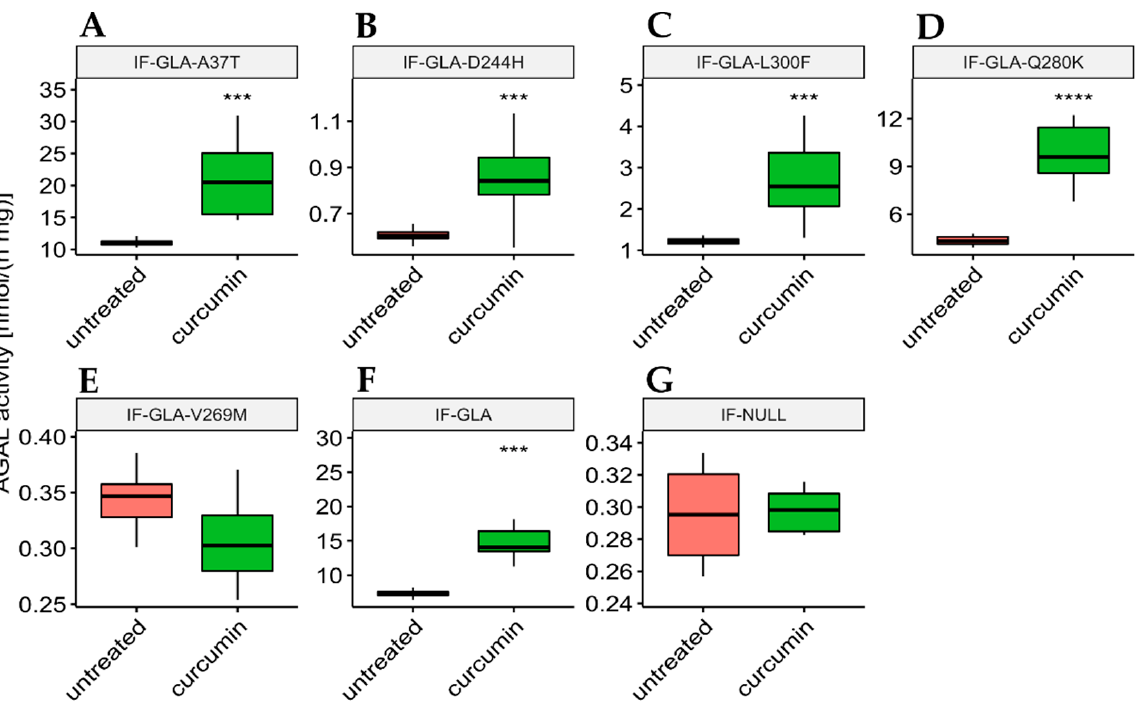
Figure 1. Curcumin treatment enhanced AGAL activity. IF-GLA and IF-GLA-MUTs were treated with 20 μ M curcumin for 48 h. The AGAL-specific activity was then tested on cell protein extracts. Wild-type cells and four mutants showed a significant AGAL improvement upon curcumin treatment (two-tailed unpaired t -test, *** = p < 1 × 10 − 3 , **** = p < 1 × 10 − 4 ). ( A ) IF-GLA-A37T: n = 9, p . 1.85 × 10 − 4 ; ( B ) IF-GLA-D244H: n = 12, p . 1.02 × 10 − 4 ( C ) IF-GLA-L300F: n = 10, p . 1.43 × 10 − 4 ; ( D ) IF-GLA- Q280K: n = 6, p . 9.68 × 10 − 5 ; ( E ) IF-GLA-V269M: n = 6, p . 1.08 × 10 − 1 ( F ) IF-GLA: n = 7, p . 5.72 × 10 − 4 . IF-NULL cells were used as a negative control ( G ).